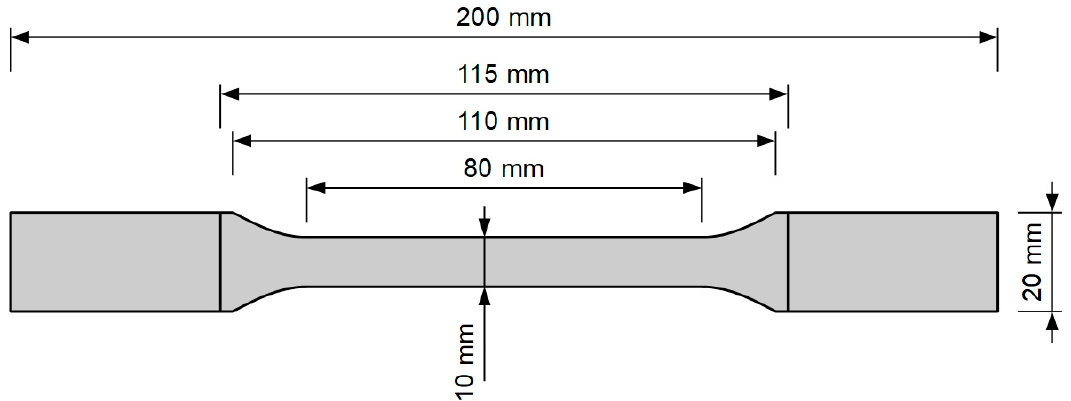
Figure 2. Dimensions of a dogbone specimen.